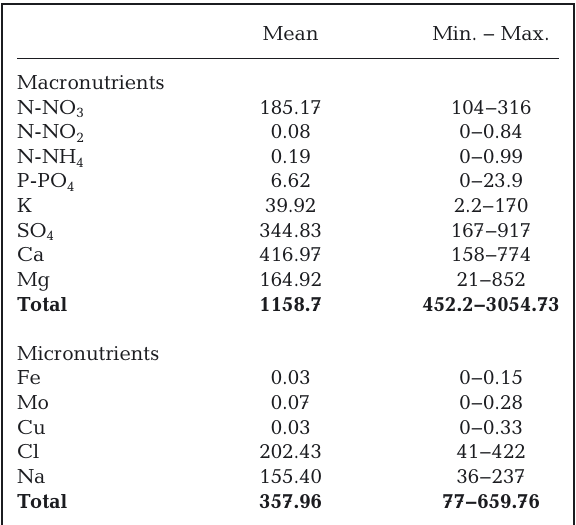
Table 2. Mean, minimum, and and maximum concentrations (mg l −1 ) of macro- and micronutrients in the hydroponic unit (nutrient film technique, NFT) during the course of the testing Mean Min. − Max.